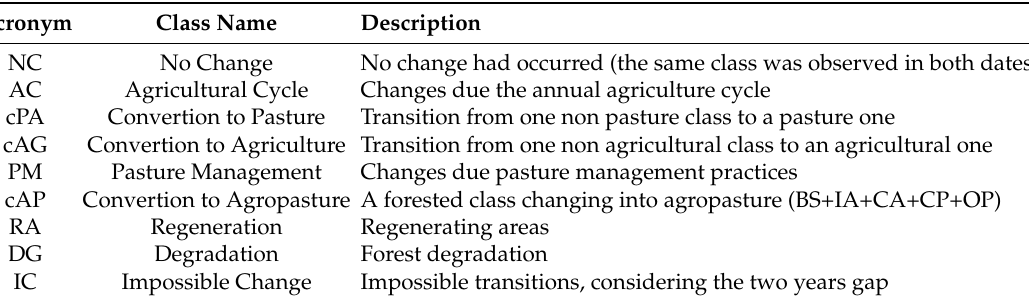
Figure 8. Processes that results in each land cover class. Note: The agricultural classes are Bare Agricultural Soil, Idle Agricultural Area and Cultivated Area. The pasture classes are Clean Pasture and Overgrown Pasture. Table 3. Collapsed change classes